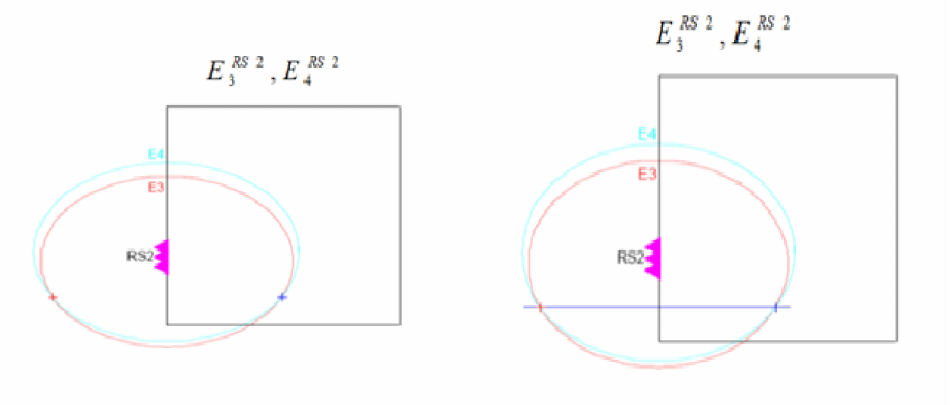
Figure 3. Intersections of RS2 ellipses.